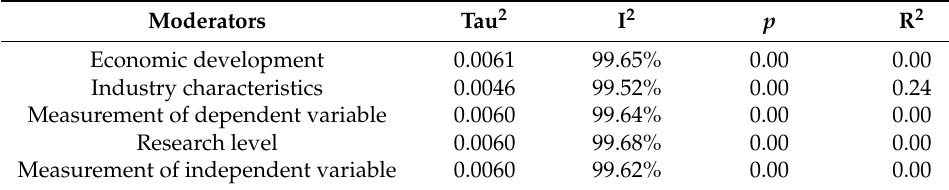
Table 2. Meta-regression analysis